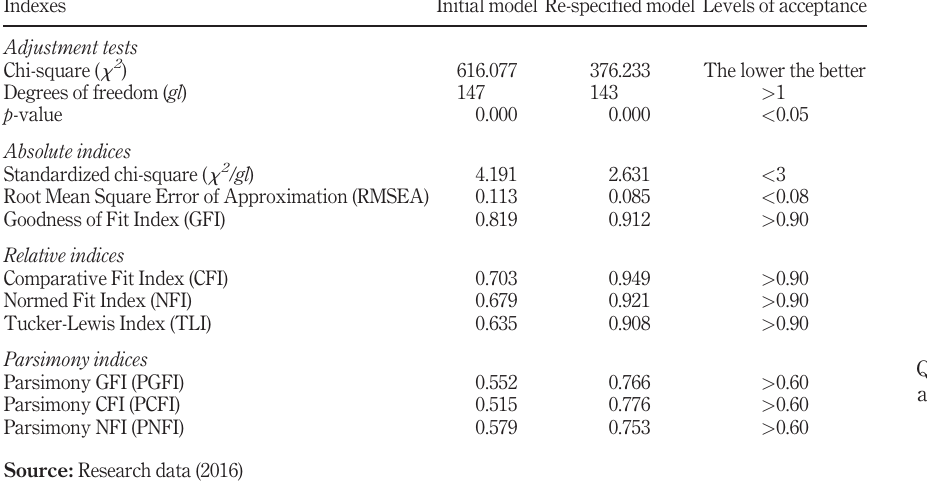
Table III. Quality indices